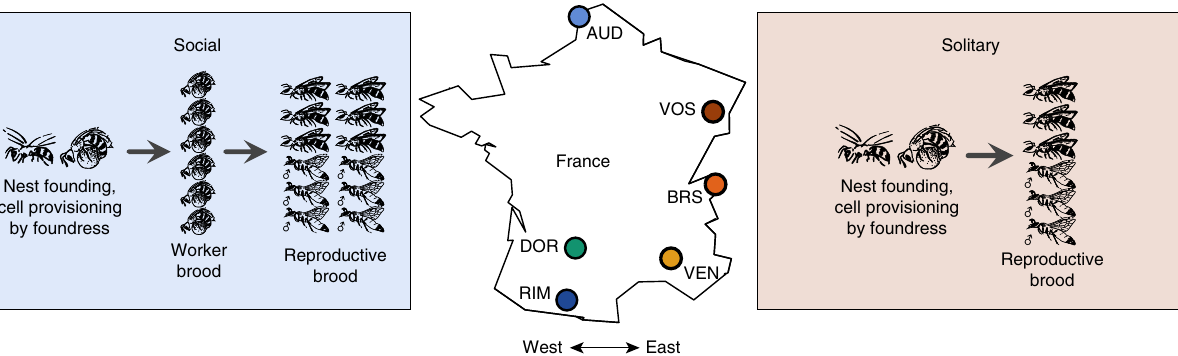
Fig. 1 The socially polymorphic halictid bee L. albipes . Populations in western France are eusocial (blue and green colors), while populations in the east are solitary (red and orange colors). Eusocial females produce two broods: fi rst workers, then reproductives, while solitary females produce a single, reproductive brood. This variation is strongly correlated with season length and mean temperature, with eusocial populations in regions with longer seasons and a warmer mean temperature than solitary populations 3 . Drawings by W.